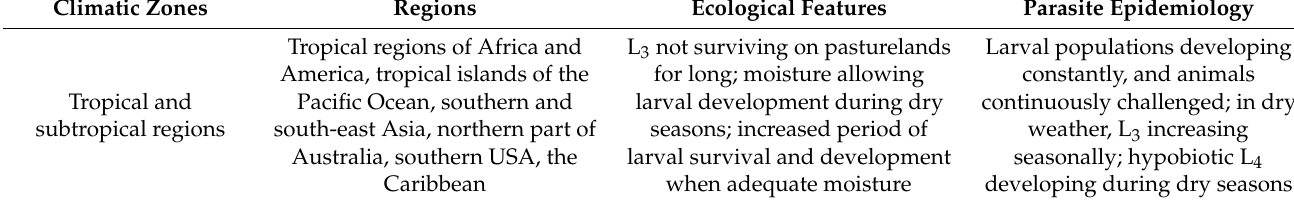
Table 1. Summary of epidemiological features of Haemonchus contortus infections according to climatic regions. Climatic Zones